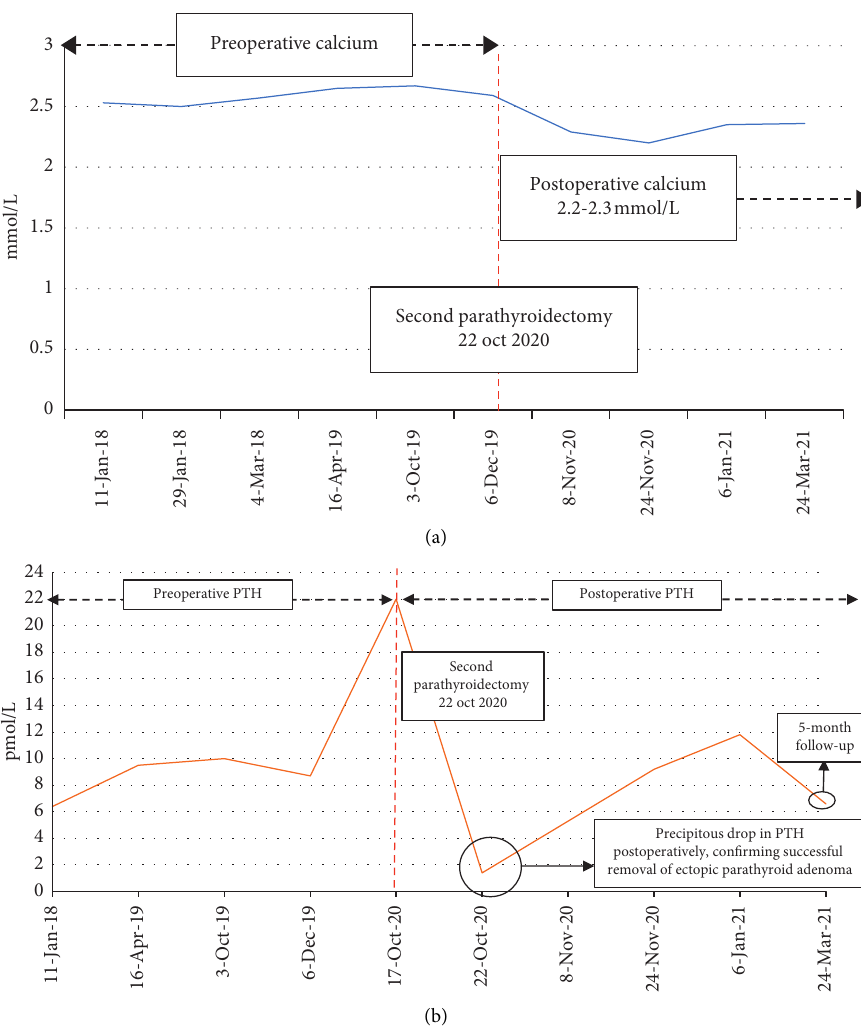
Figure 1: Calcium and parathyroid hormone (PTH) before and after second